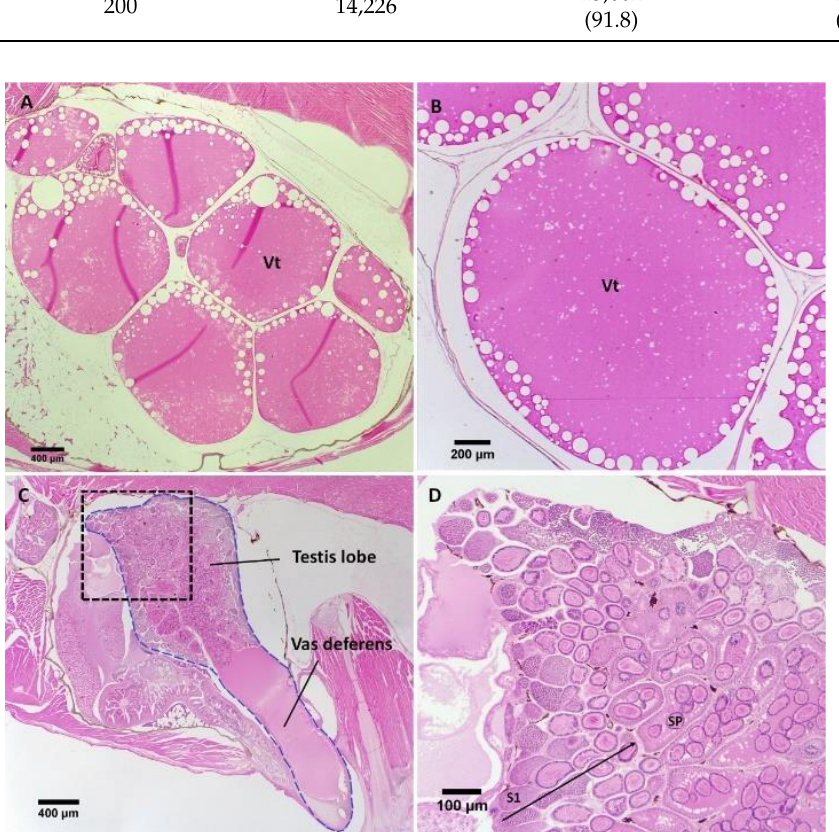
Figure 5. Sagittal sections through gonads of control adult female ( A , B ) and male ( C , D ) G. holbrooki . ( A ) Vitellogenic oocytes (Vt) typically occupied most part of ovarian cavity and ( B ) vitellogenic oocytes at higher magnification. ( C ) Testis (bound by the blue broken line) showing anterior glandular tissue and posterior vas deferens with ( D ) higher magnification (of the section framed by black broken line in ( C ) showing advancing stages of spermatogenesis from periphery towards central lumens (indicated by the direction of large arrow). Primary spermatocytes (S1) were located at the periphery of the testis while spermatozeugmata (SP) were presented in central lumens. Anterior to left and posterior to